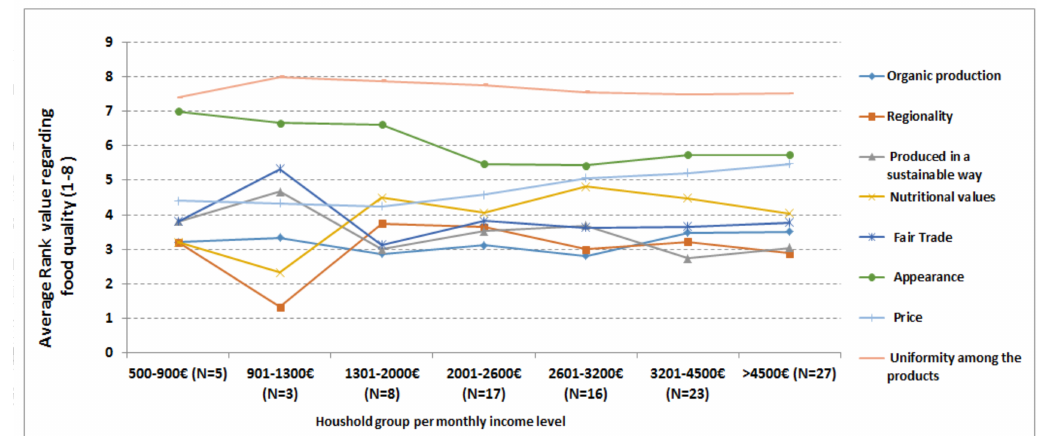
Figure 3. Description of food quality ranking according to income level-based household groups ( N = 99).